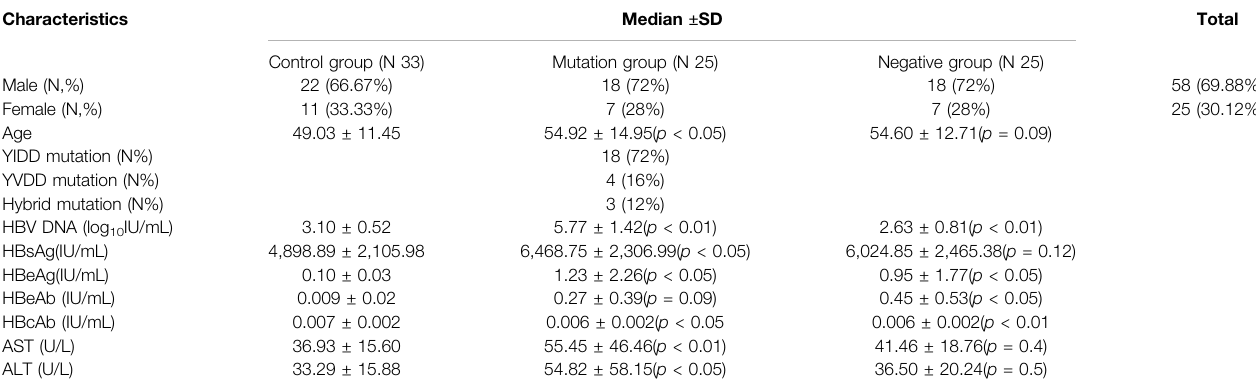
TABLE 1 | Clinical characteristics. Characteristics